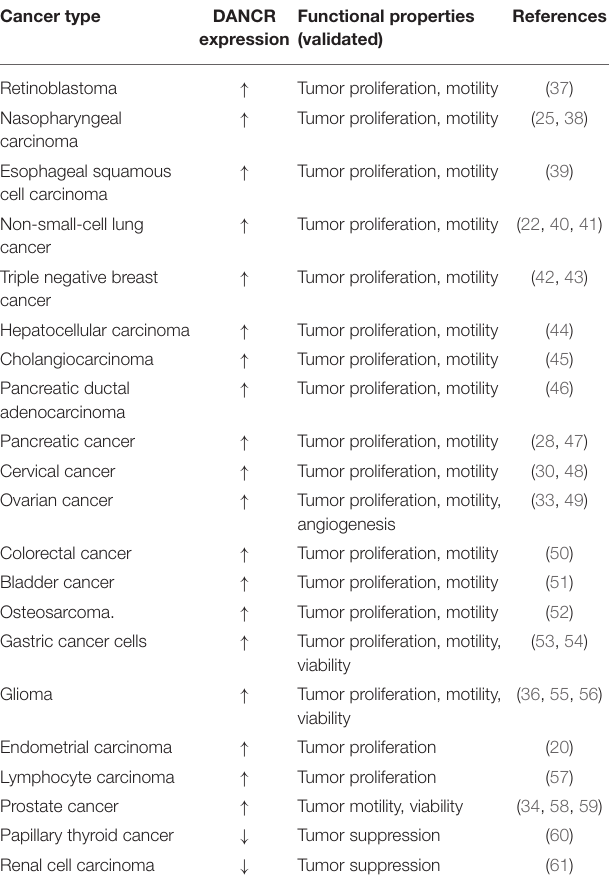
TABLE 1 | Functions of DANCR in human